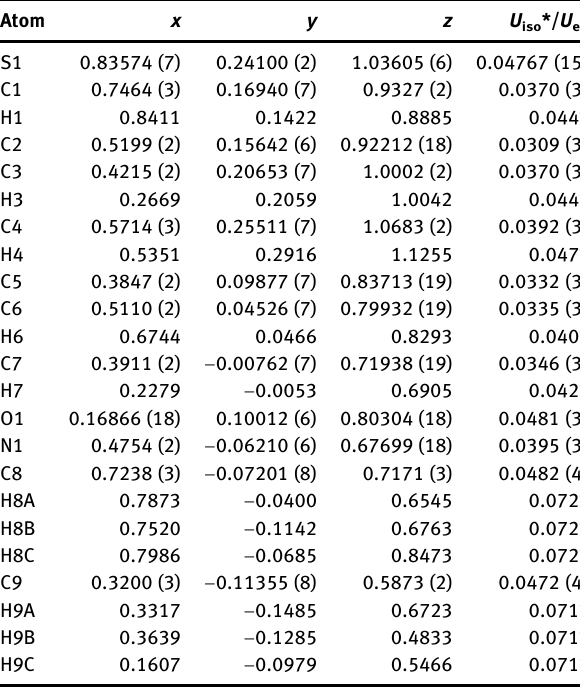
Table  : Fractional atomic coordinates and isotropic or equivalent isotropic displacement parameters (Å 